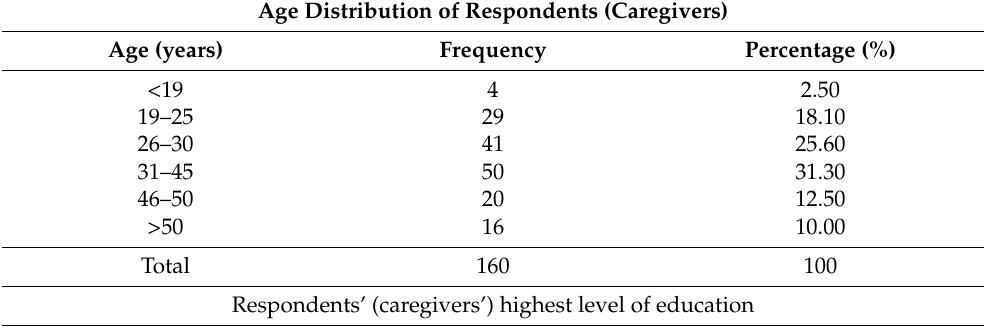
Table 1. Household with children and respondents (caregivers) demographic characteristics.